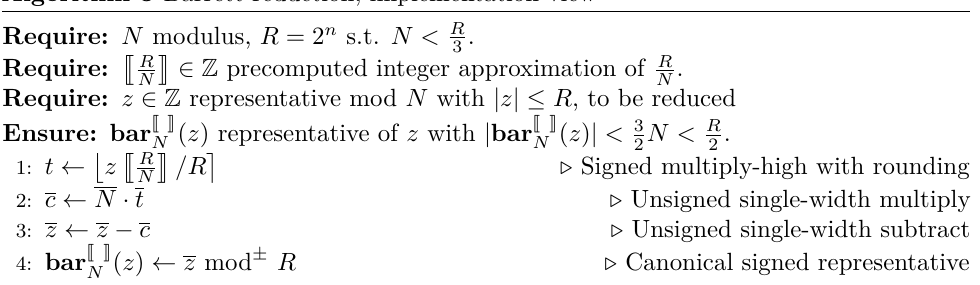
Algorithm 3 Barrett reduction, implementation-view